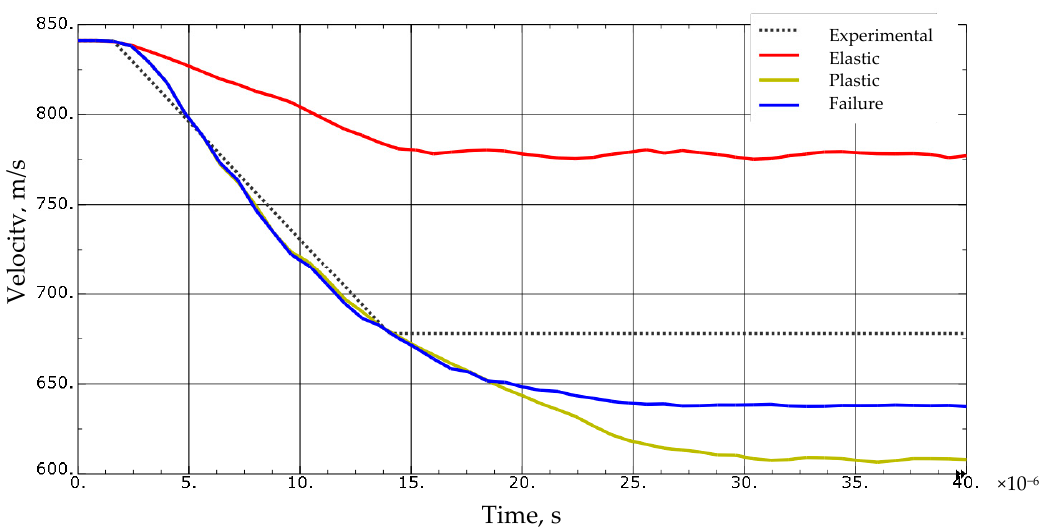
Figure 5. A comparison of projectile velocity drops depending on the projectile model used. Simulation of shooting at a 4 mm thick sample of 1.3964 steel.